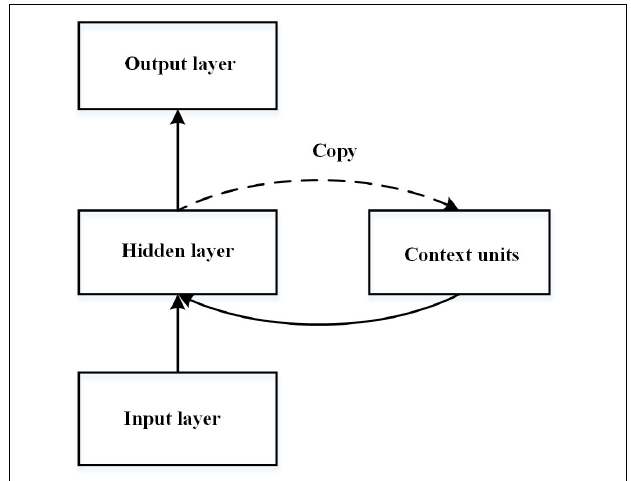
FIGURE 1 | Schematic diagram of the simple recurrent network introduced by Elman